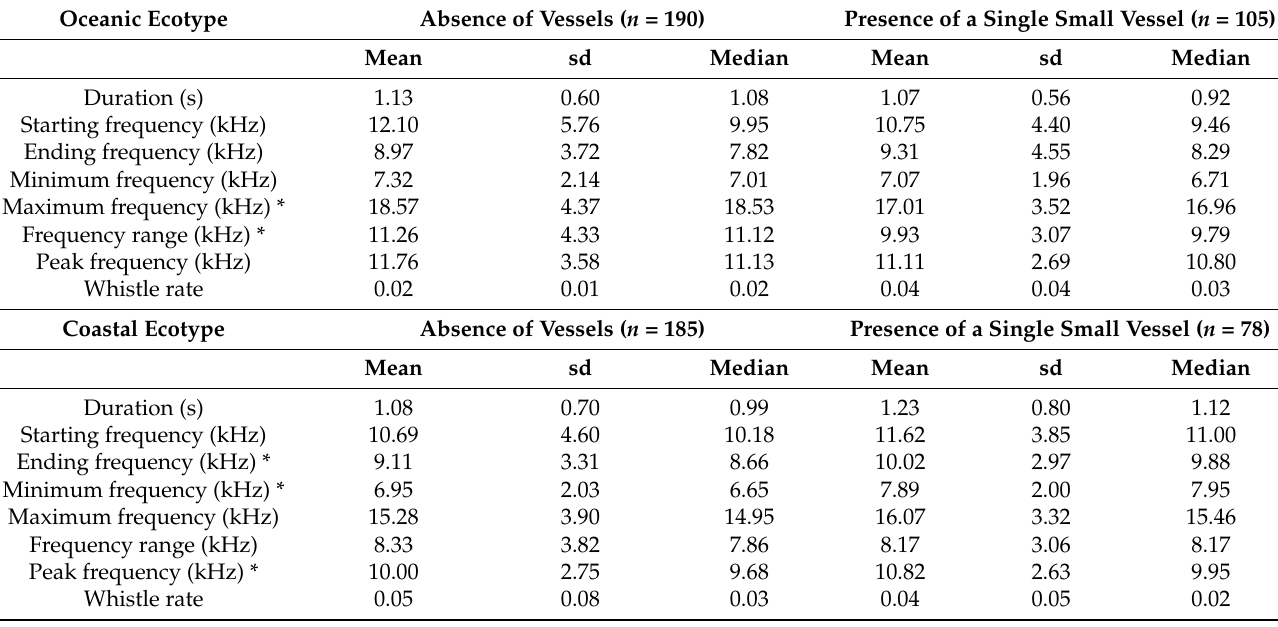
Table 3. Descriptive statistics of the whistle parameters and rates of the two bottlenose dolphin ecotypes in absence of vessels and in presence of a single small